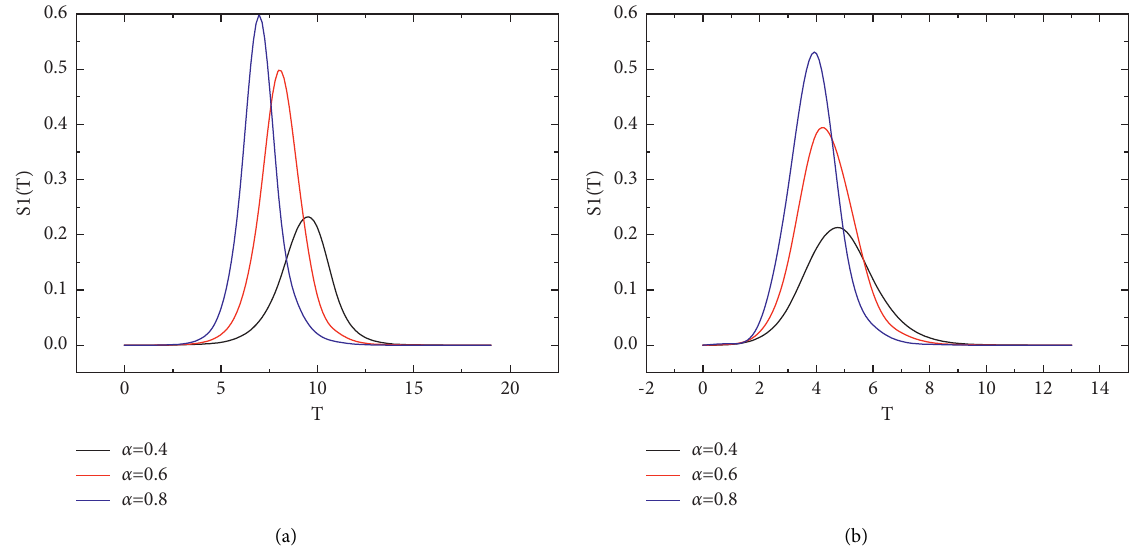
Figure 4: Density of spreader 1 over time for different values of α . (a) WS small-world network. (b) BA scale-free